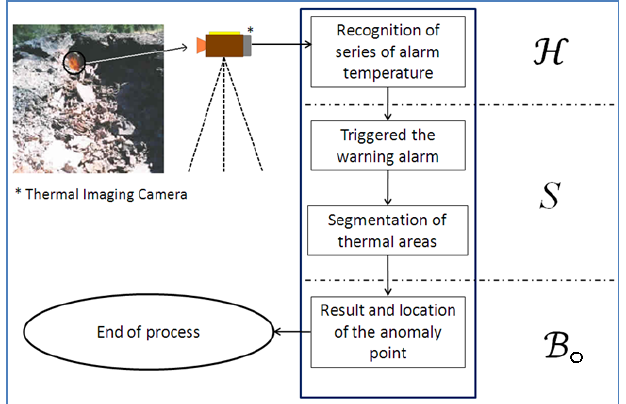
Figure 1. Basic flow of the